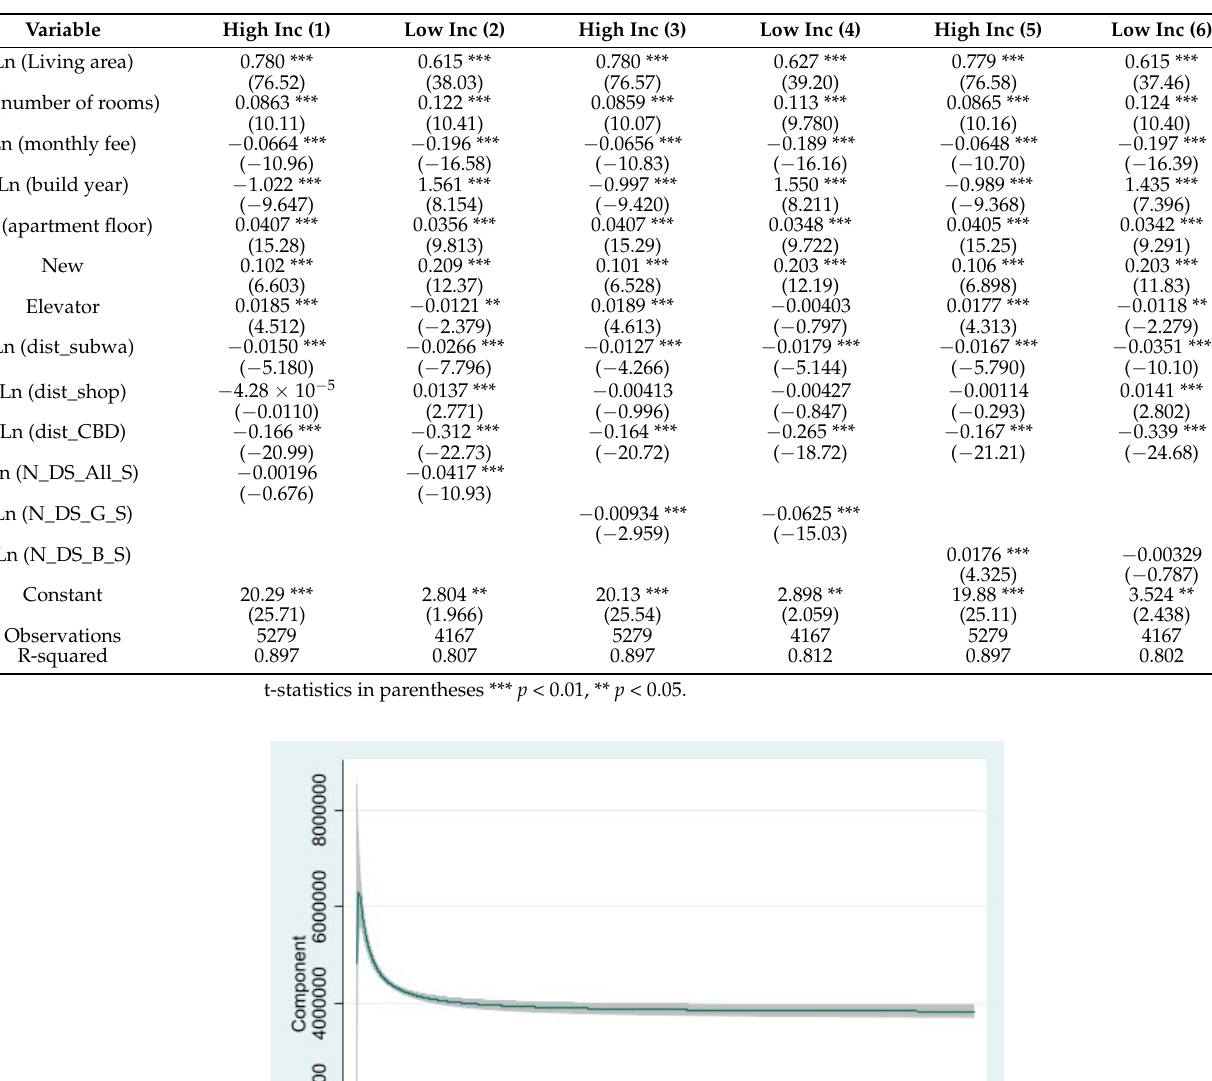
Table 6. HPM results are controlled by income for Measure 1.